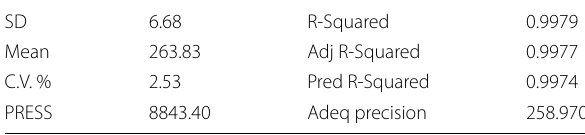
the experimental relationships extracted from Eq. 6 is as follows: